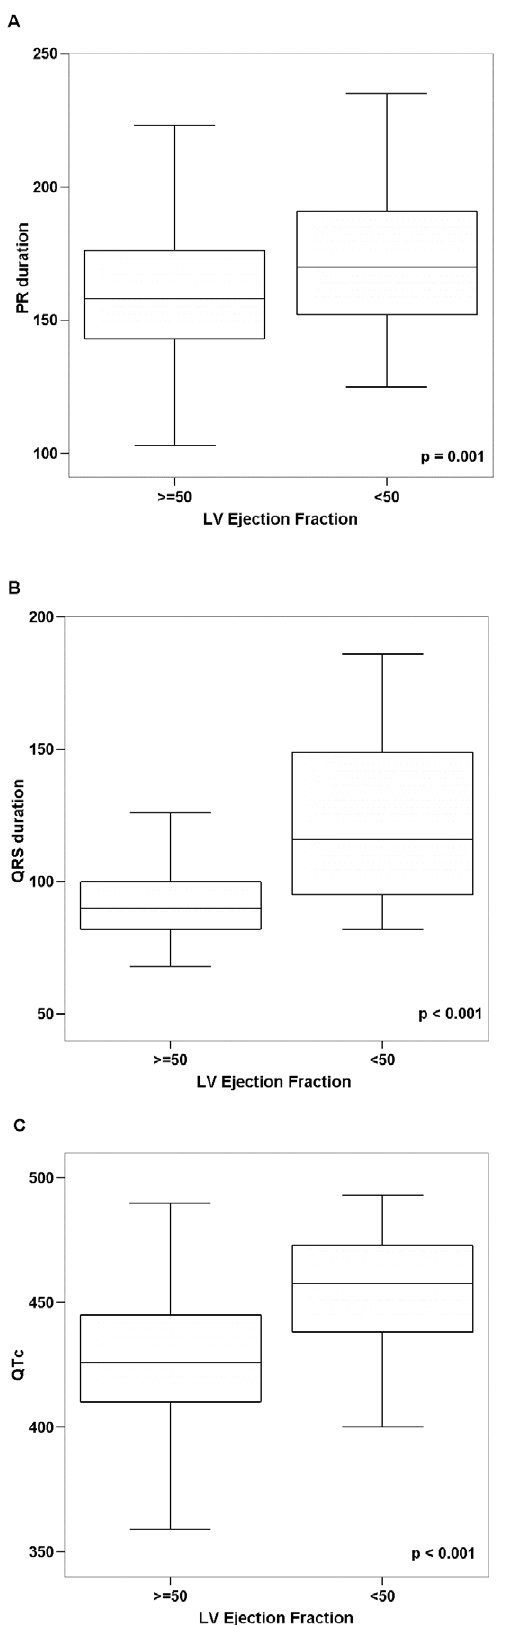
Figure 1. Quantitative ECG measurements in T.cruzi seroposi- tive blood donors by left ventricular ejection fraction. A. PR